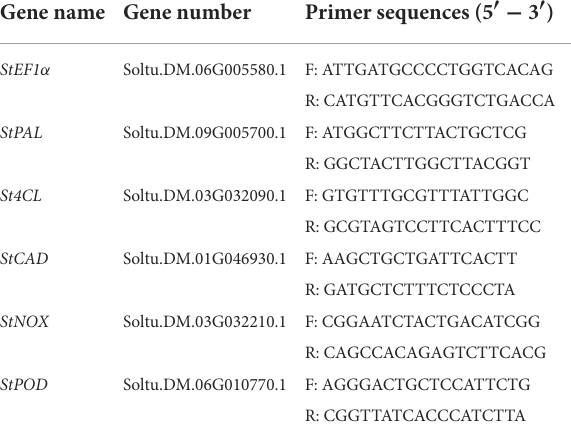
TABLE 1 Primer sequences used in this